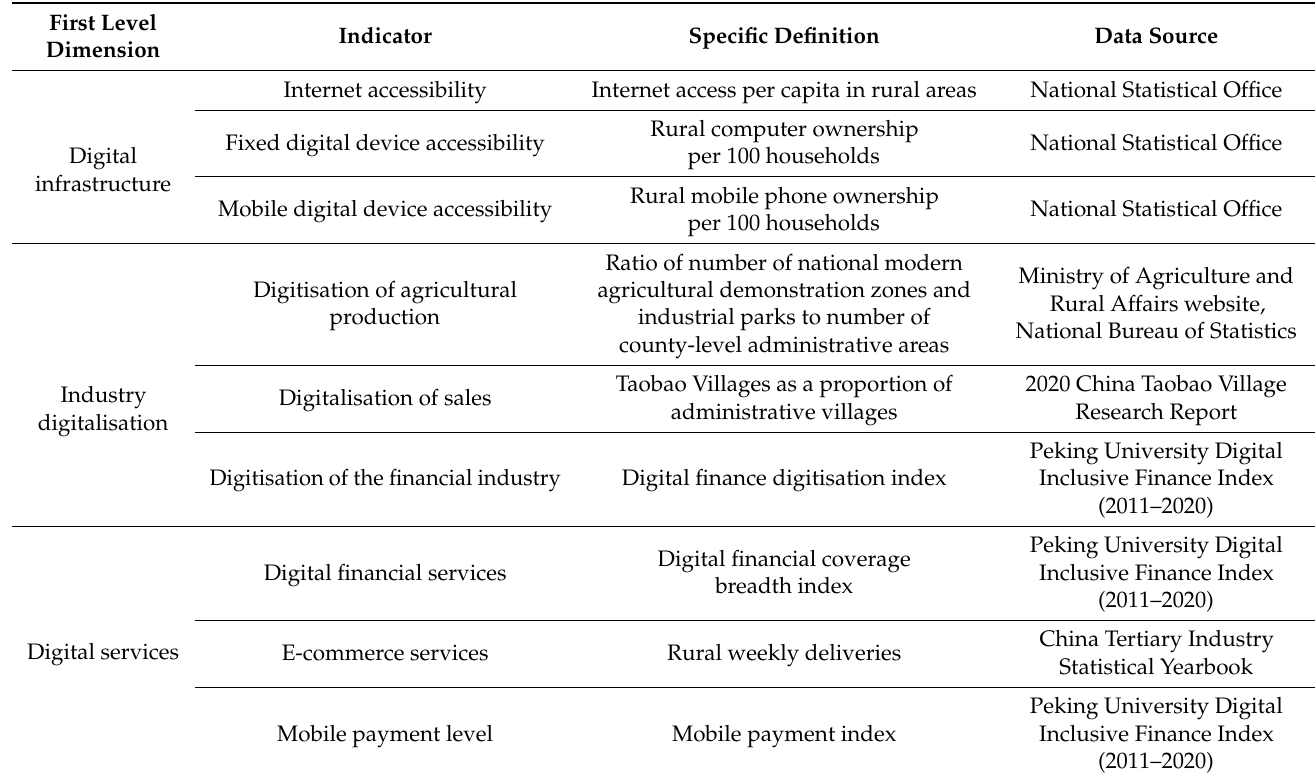
Table 2. Digital village construction level evaluation index